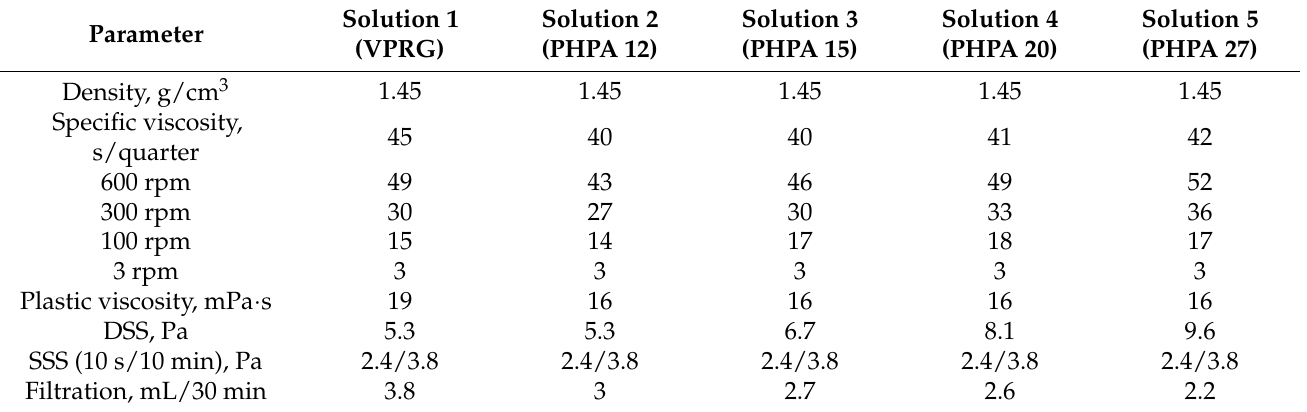
Table 4. Parameters of the investigated drilling